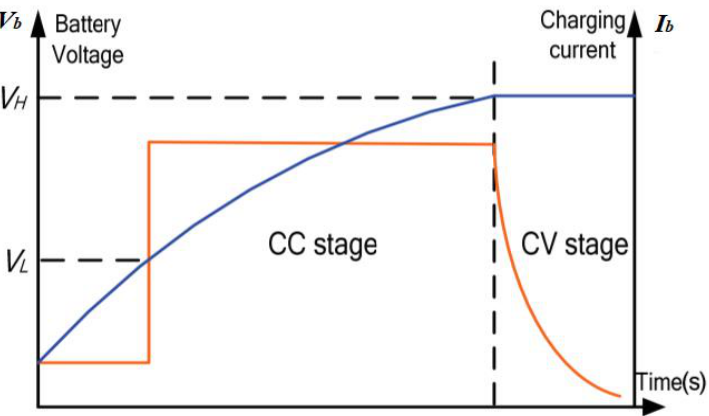
Figure 7. Charging strategy of a lithium-ion battery.